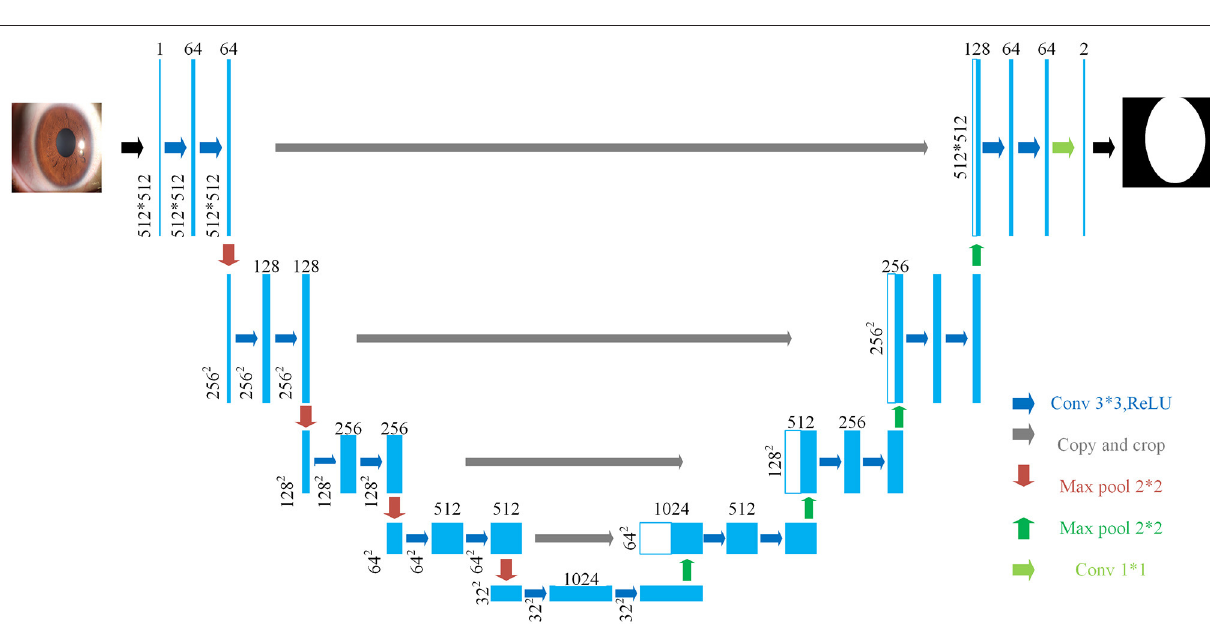
FIGURE 3 | The structure of